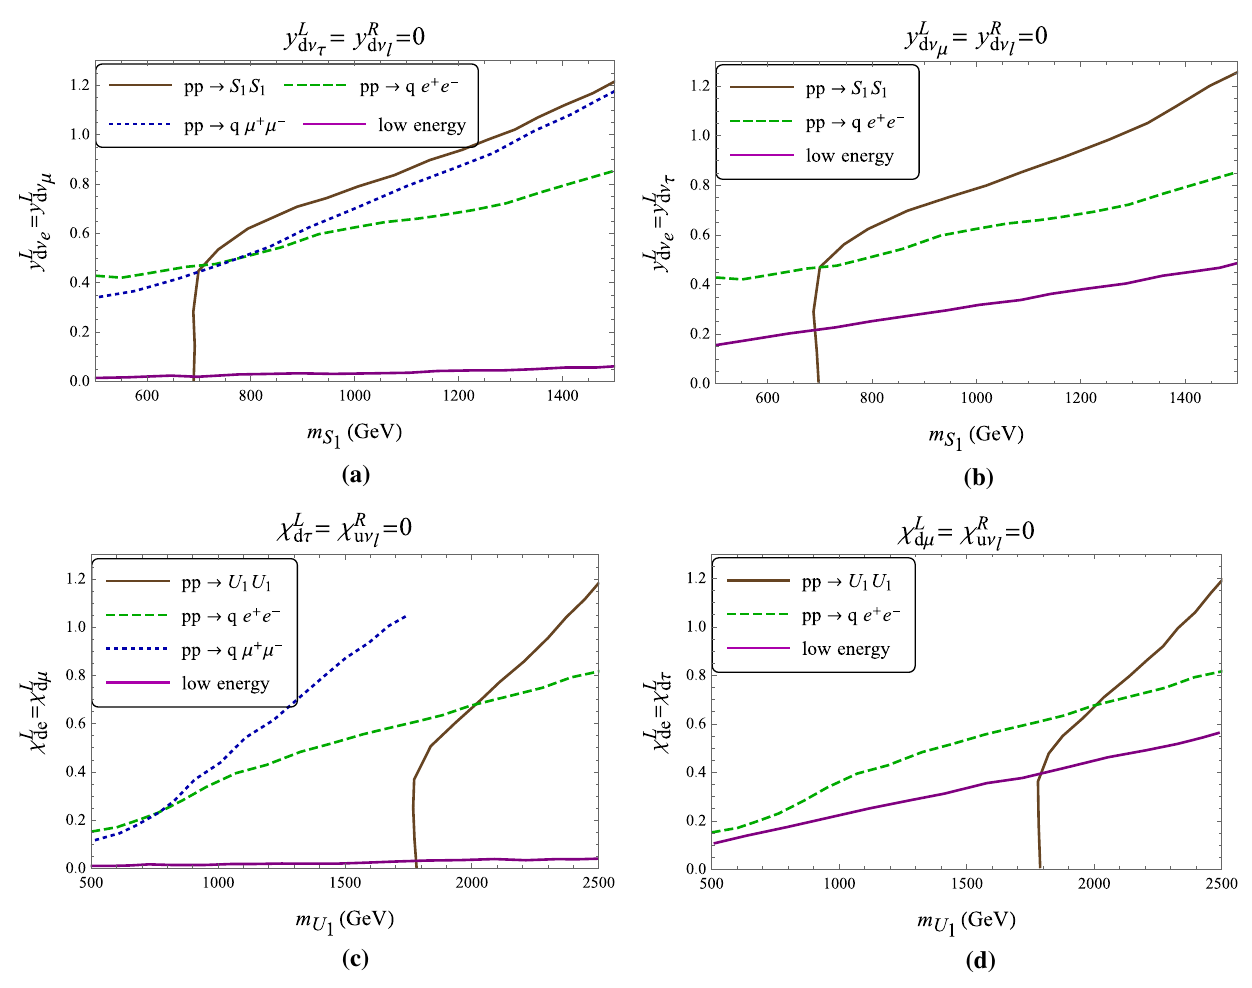
Fig. 2 The allowed parameter space in case of S 1 and U 1 from differ- ent experiments discussed in the text. The area below the brown (blue and green) line is compatible with the LQ searches through pair (sin-